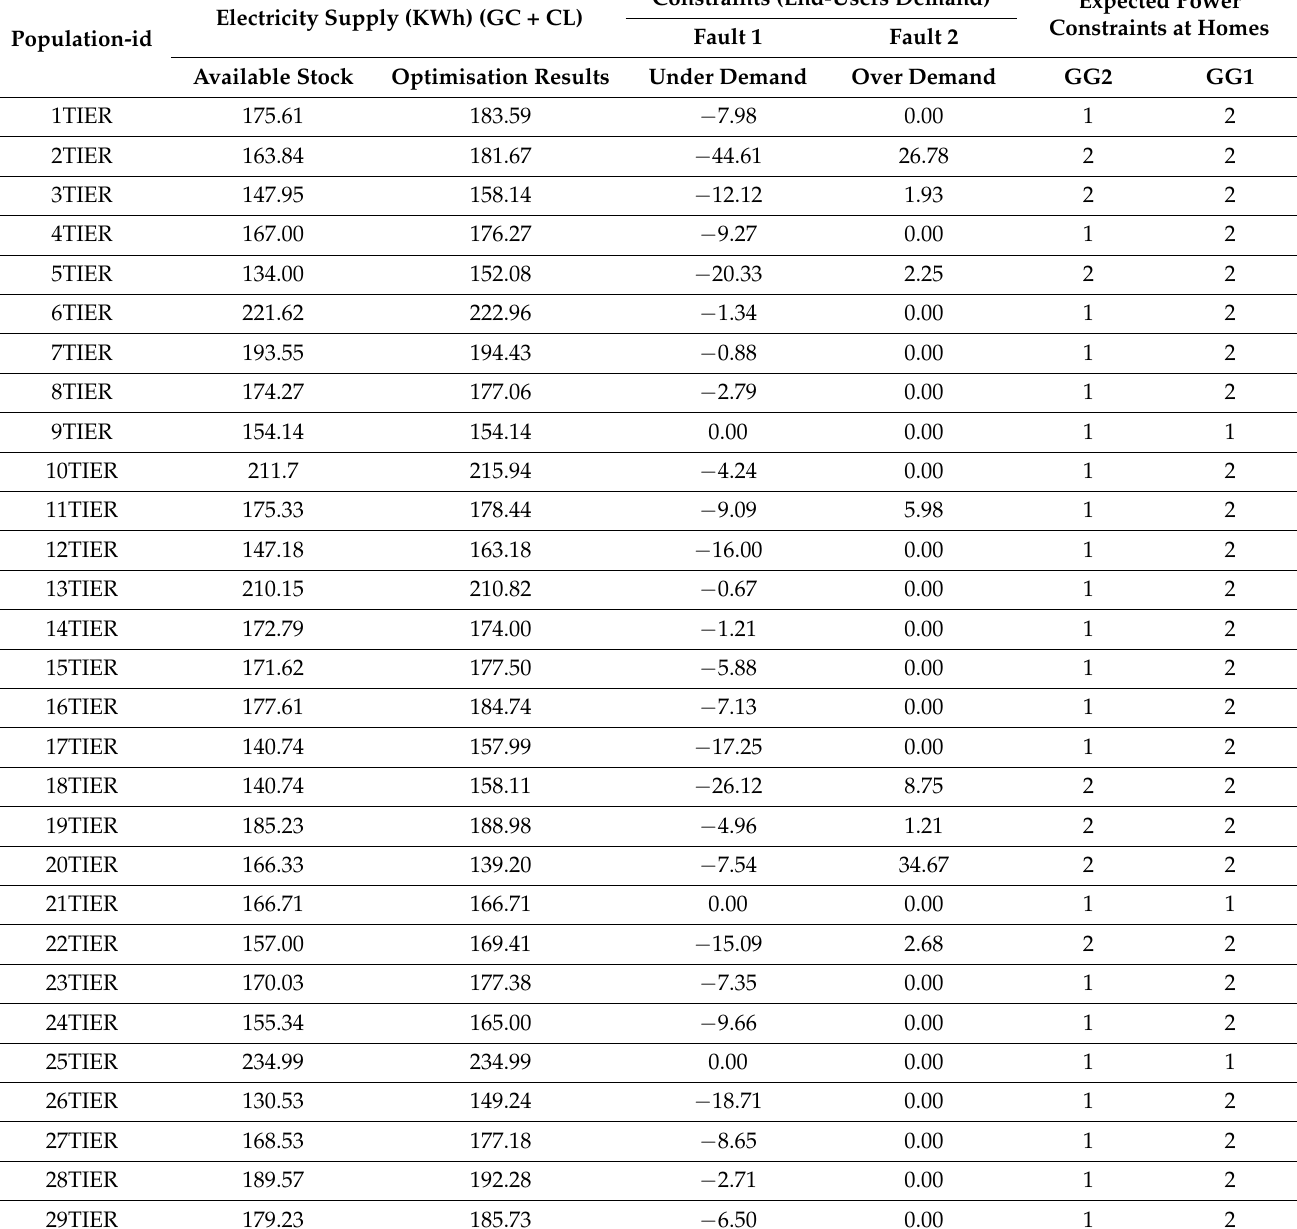
Table 9. Losses Cost Simulation and